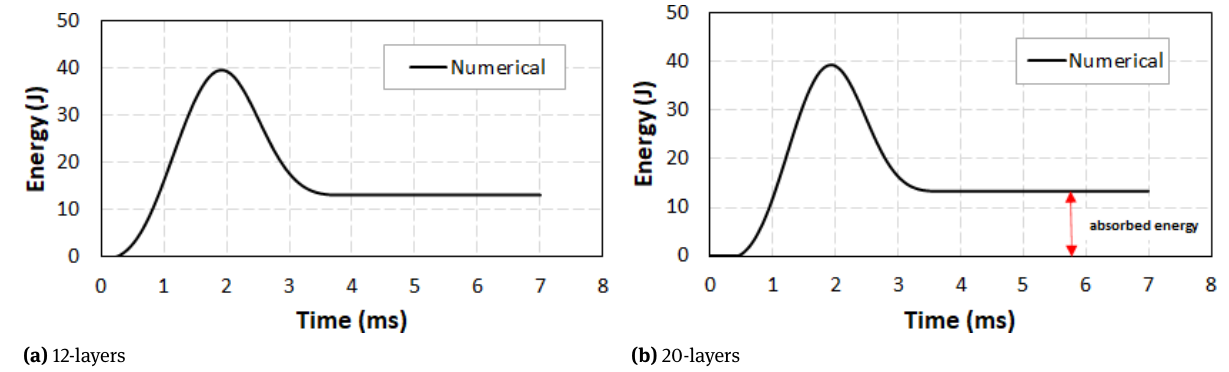
Figure 11: Numerical energy absorption of UHMWPE reinforced